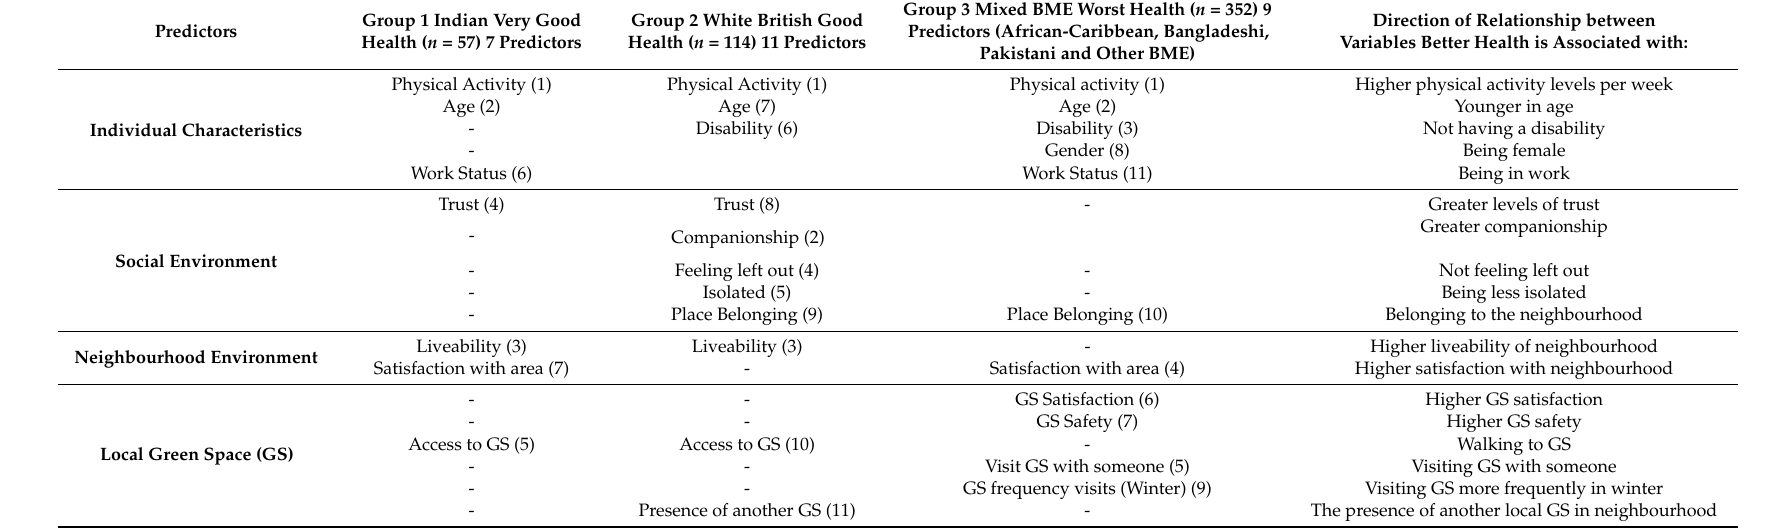
Table 3. Predictors of general health by health group (rank order of predictors shown in